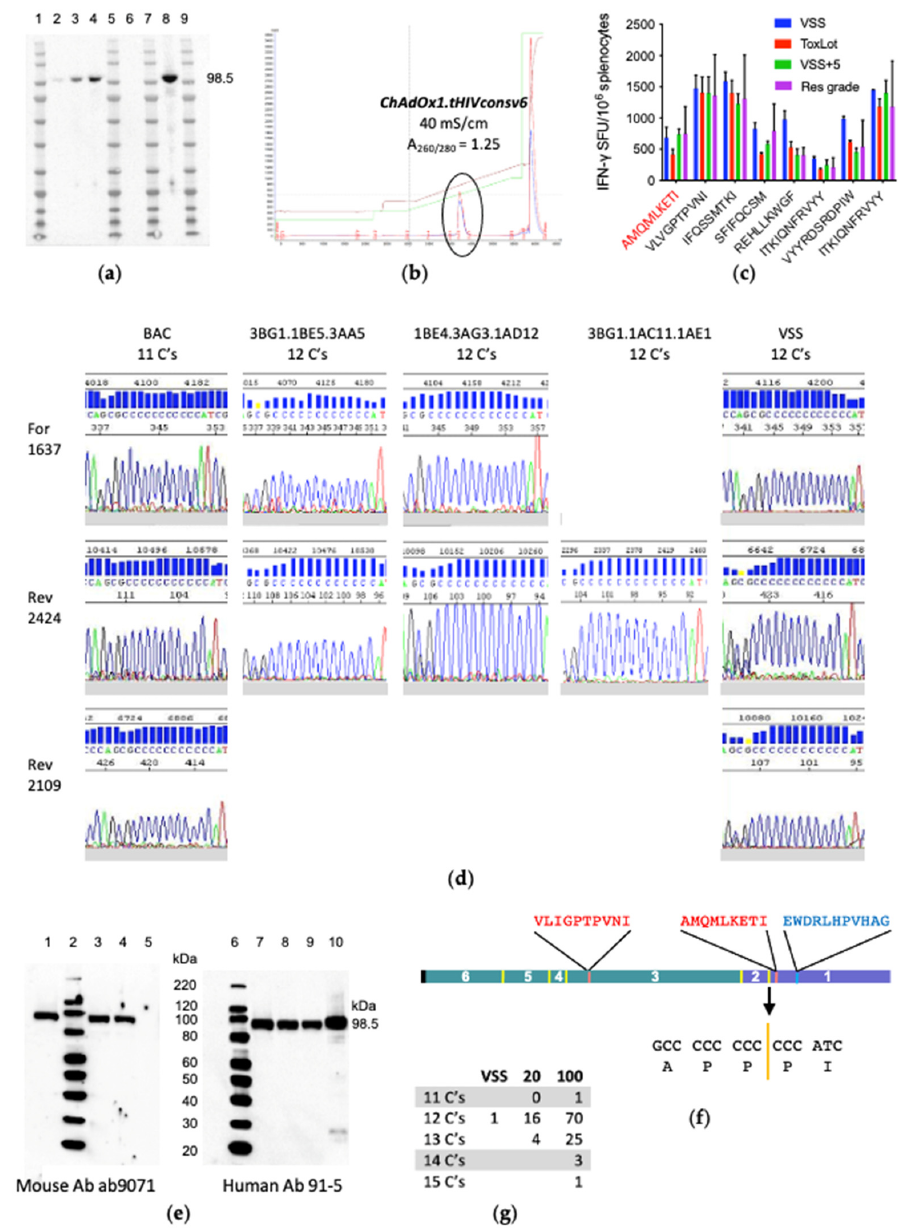
Figure 3. The VSS quality control. ( a ) The VSS established from clone 3BG1.1AC11.1AE1 was tested for genetic stability over five blind passages in the M9.S suspension cells (VSS+5), and the tHIVconsv6 protein expression was assessed in HeLa cells infected at vp MOIs of 2, 20 and 200 (lanes 2–4).